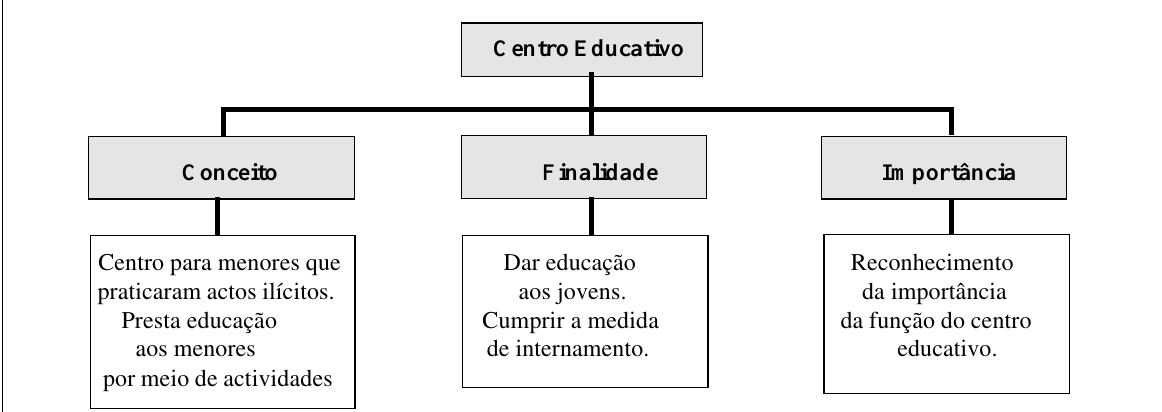
Figura 2 . Excerto de entrevista e respectivo mapa conceptual de T.G.E. Categoria: medida de internamento. Subcategoria: Centro Educativo